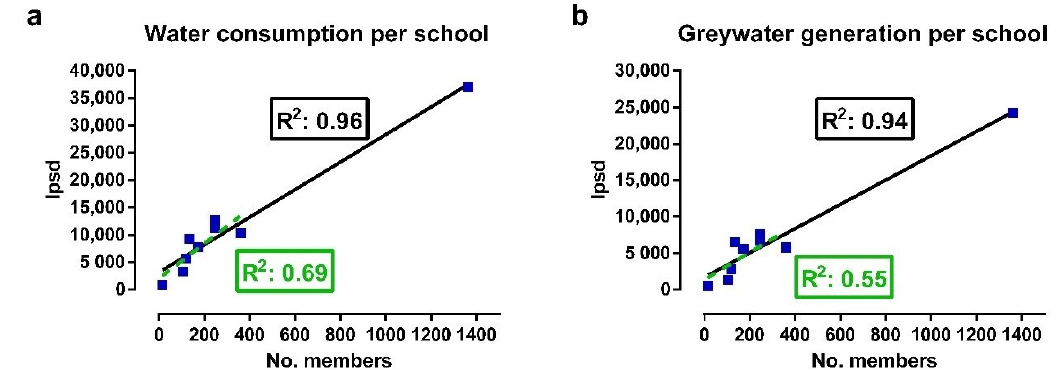
Figure 4. Relationship between the number of members in each school and ( a ) the water consumption and ( b ) the greywater generation per school. The trend lines are presented in black and continuous lines (9 schools) and green and dashed lines (excluding Ovalle Polytechnic).